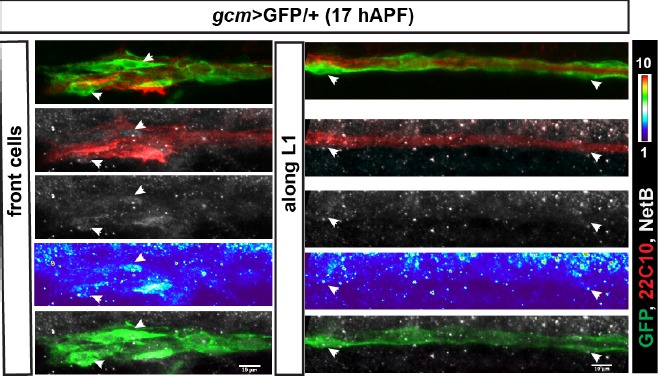
DOI:
http://dx.doi.org/10.7554/eLife.15983.030